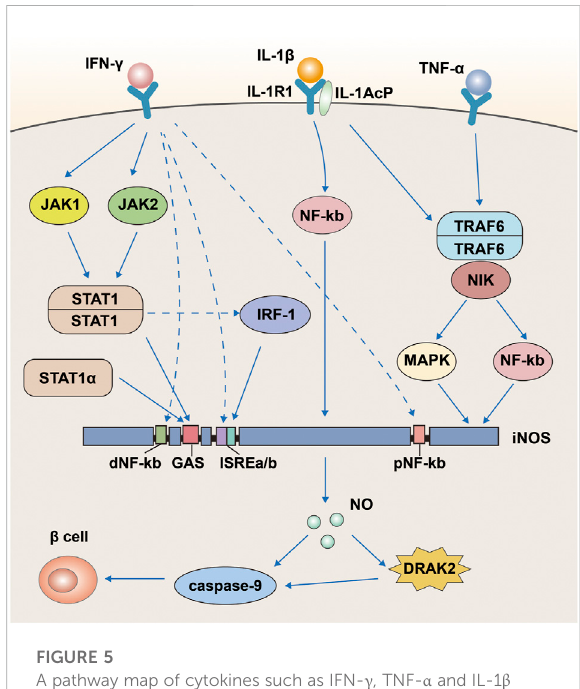
FIGURE 5 A pathway map of cytokines such as IFN- γ , TNF- α and IL-1 β that promote apoptosis in pancreatic β -cells via